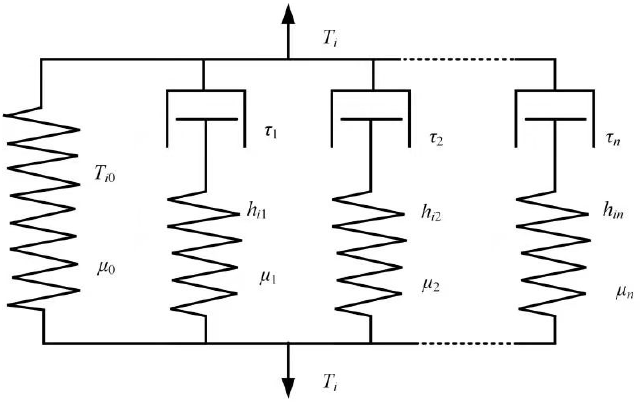
Figure 25. The viscoelastic model by Geibler and